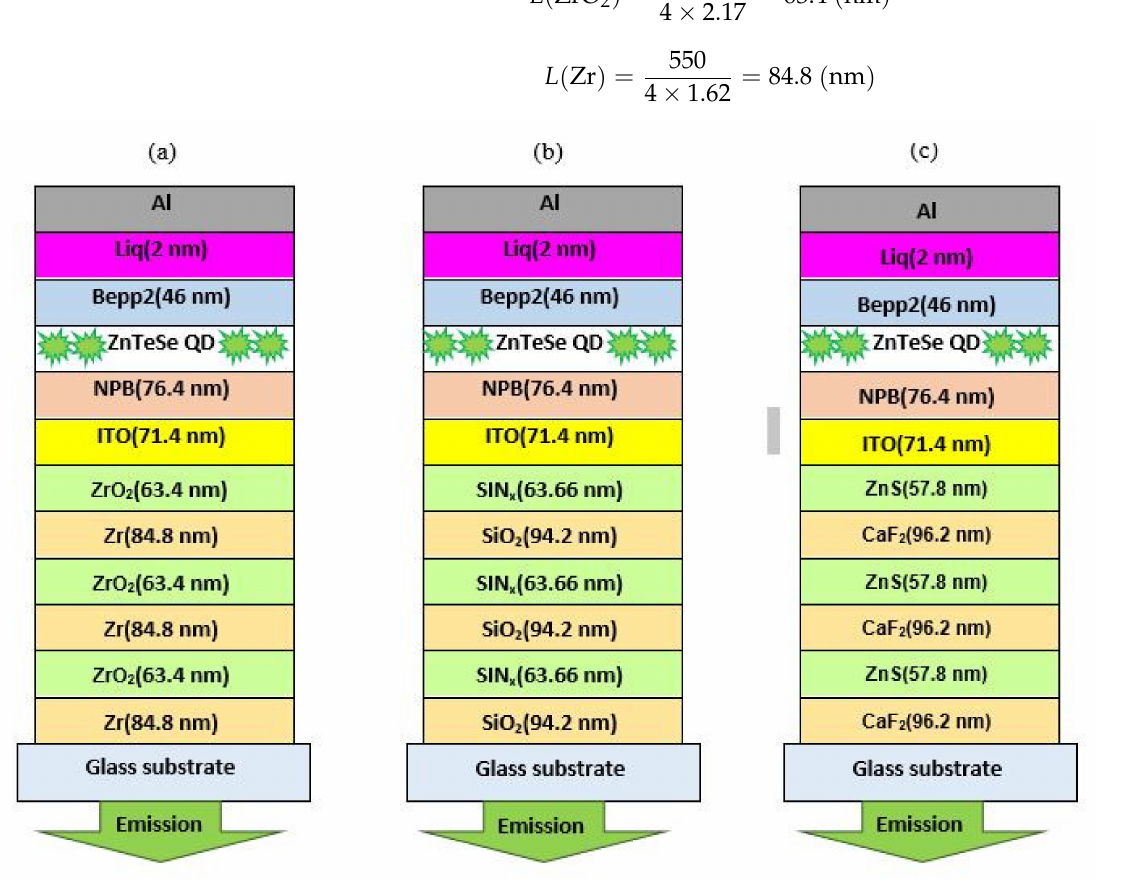
Figure 5. Schematic layer structure of three devices at 550 nm based on ( a ) DBR1 ( b ) DBR2 ( c )